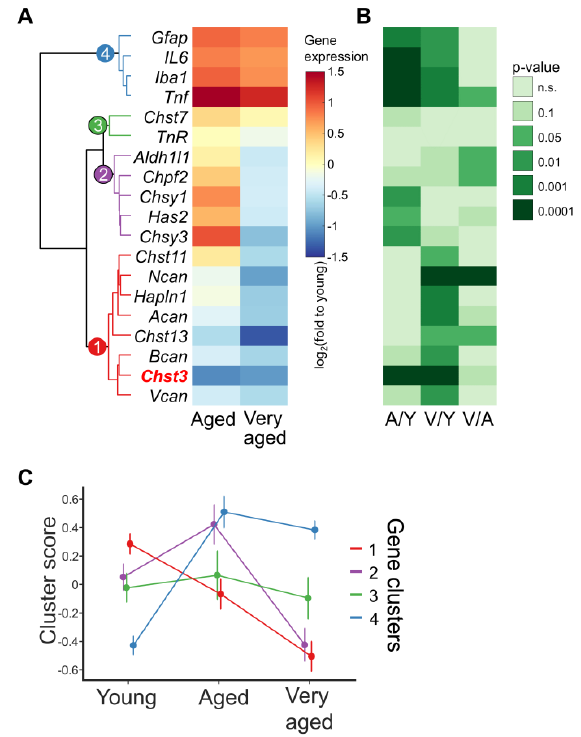
Figure 2. Comparison of aging-associated changes in expression of ECM, proinflammatory and cell-type-specific genes. ( A ) Changes in the expression of the studied genes compared to young animals (log 2 fold change); ( B ) the level of statistical significance for comparisons aged vs. young (A/Y), very aged vs. young (V/Y) and very aged vs. aged (V/A) are shown on a heat map with different green intensity. These p -values were calculated by shuffling the mice-group relationship ( n resampling 10 4 ). ( С ) Four patterns of gene expression dynamics during aging. The studied genes were divided into clusters, using inter-age correlation as a measure of distance (see also Supplementary Figure S1). The details of the age-only correlation analysis are described in Materials and Methods.